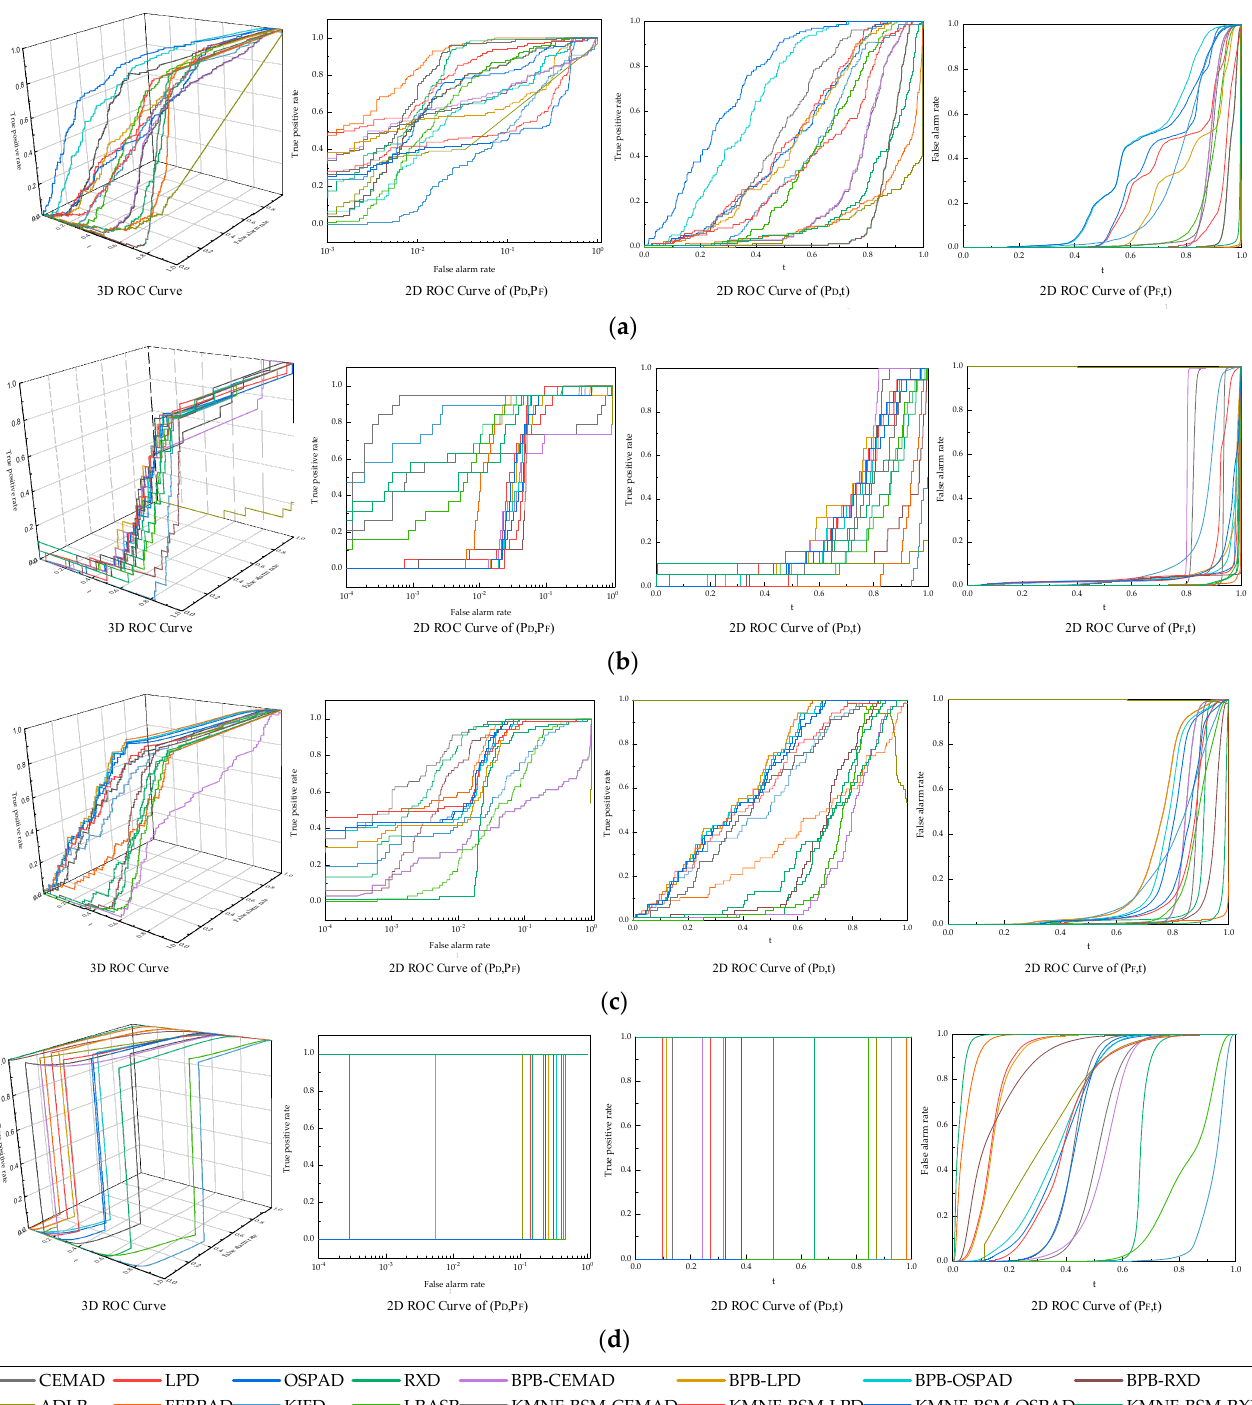
Figure 8. The 3D ROC curves along with their generated three 2D ROC curves of each method for ( a ) the airport scene, ( b ) the beach scene, ( c ) the urban scene, and ( d ) the vegetation scene. As shown in Figure 8, the KMNF-BSM-based methods obtain the best ROC curves for the airport scene, the urban scene, and the vegetation scene. The 2D ROC curves of ( P D , P F ) and ( P D , t ) in the KMNF-BSM-based method are closest to the top-left corner among their compared methods, and the 2D ROC curves of ( P F , t ) in the KMNF-BSM-based method are closest to the bottom-right corner. The results show better performance of KMNF-BSM-based methods.